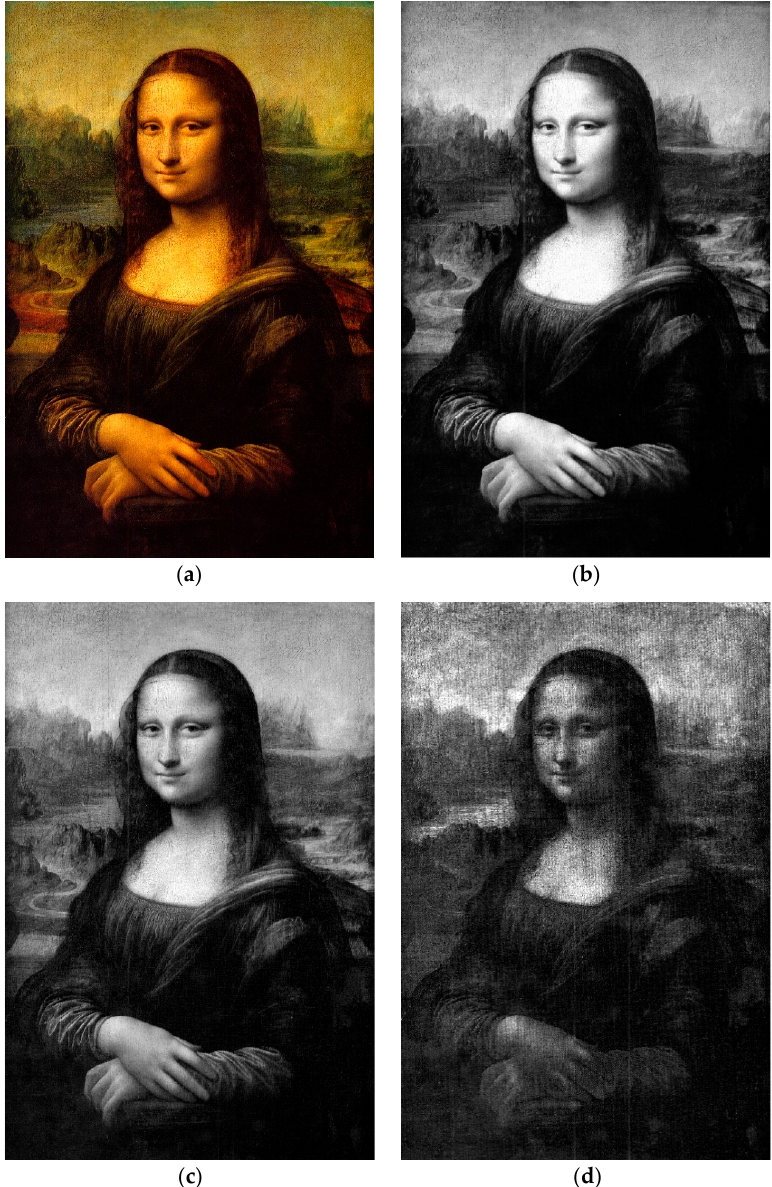
Figure 2. ( a ) Mona Lisa; ( b ) Mona Lisa R Band; ( c ) Mona Lisa G Band; and ( d ) Mona Lisa B Band.